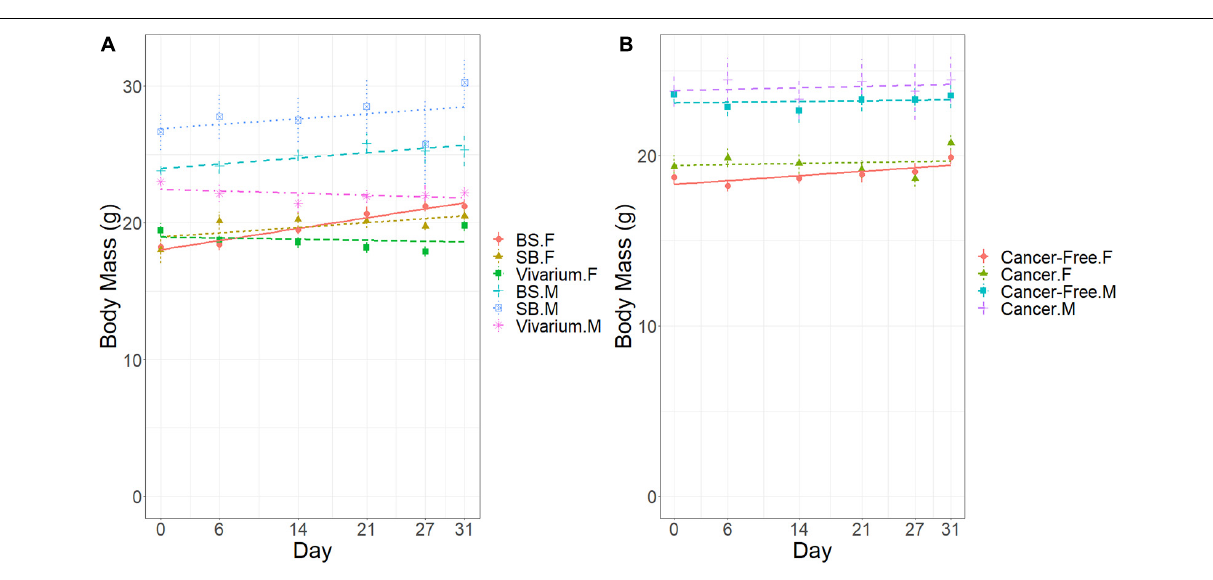
FIGURE 5 | Body mass (g) of the mice in the vivarium experiment over time (days). (A) Effects of sex (F, female; M, male) and location (Vivarium, Laboratory). (B) Effects of sex (F, female; M, male) and cancer treatment (Yes, cancer; cancer-free). Error bars represent standard errors of the